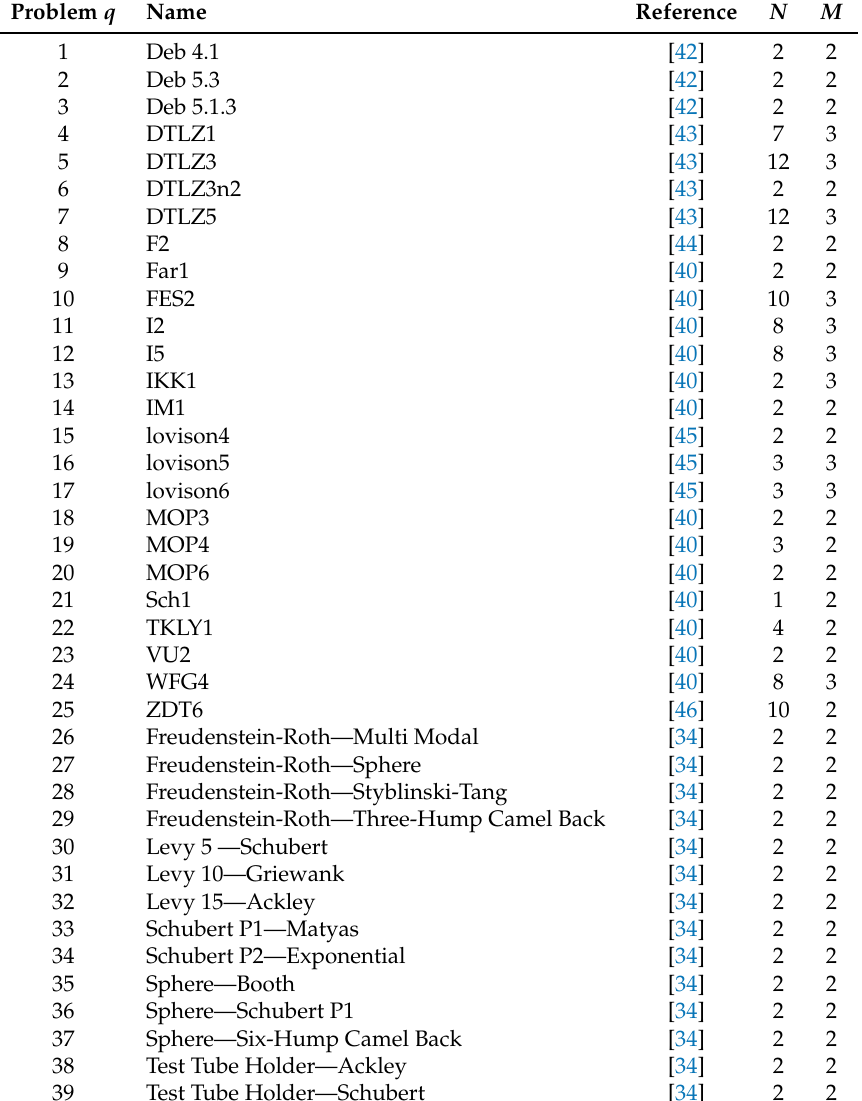
Table 1. Analytical test